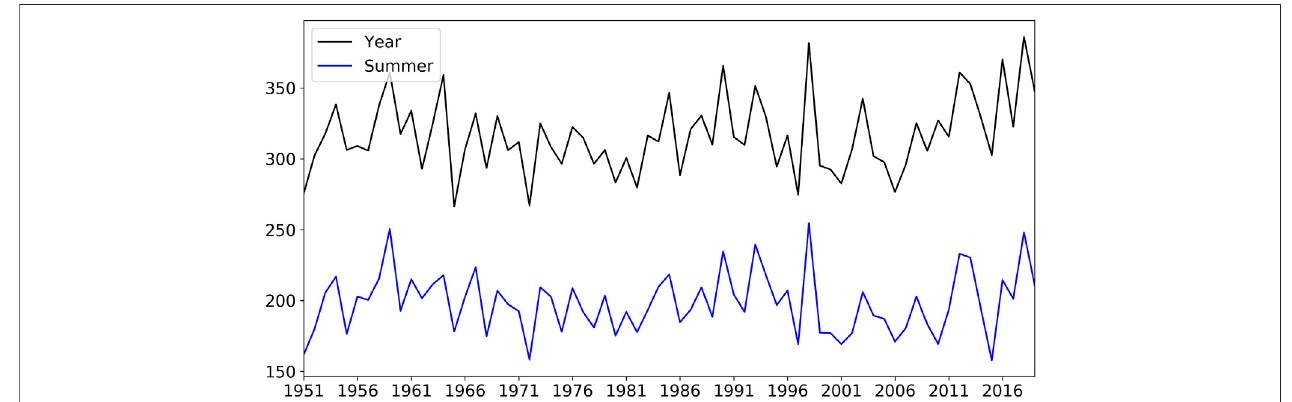
FIGURE 2 | Time series of weighted-average annual (black curve) and summer (blue curve) precipitation in the semi-arid area of East Asia during 1951 – 2019 (units: mm).